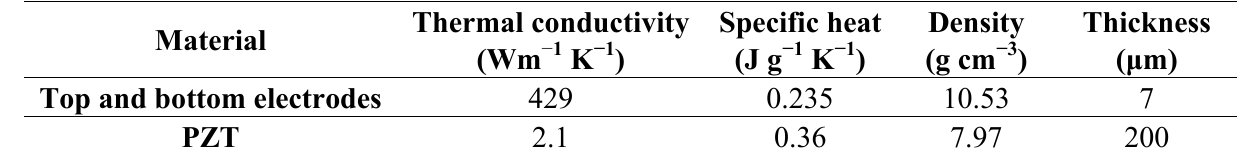
Table 1. Material parameters used for finite element